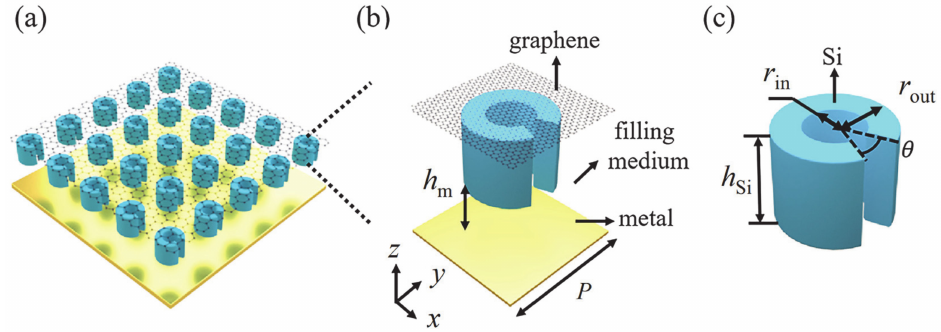
Figure 3. ( a ) Schematic diagram of the proposed graphene-dielectric reflective metasurface. ( b ) The unit cell with material and parameters specified. ( c ) Dimensions of the SRR.